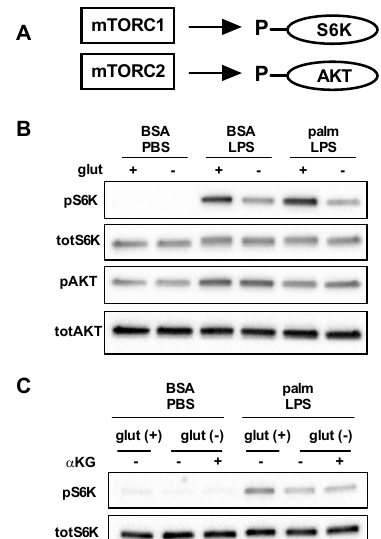
Figure 6. Glutamine deficiency impairs activation of mTORC1. ( A ) mTORC can assemble in two distinct complexes known as mTORC1 and mTORC2 which lead to the phosphorylation of S6K and AKT, respectively; ( B ) pMACs were stimulated with BSA-PBS, BSA-LPS, or palm-LPS for 16 h in the presence or absence of glutamine and phosphorlyation of S6K and AKT were assessed by Western blotting. Total S6K and total AKT are shown as control; ( C ) Macrophages were treated as indicated for 16 h in glutamine sufficient or deficient media ± α‐ KG (440 nM) and S6K phosphorylation was determined by Western blotting.